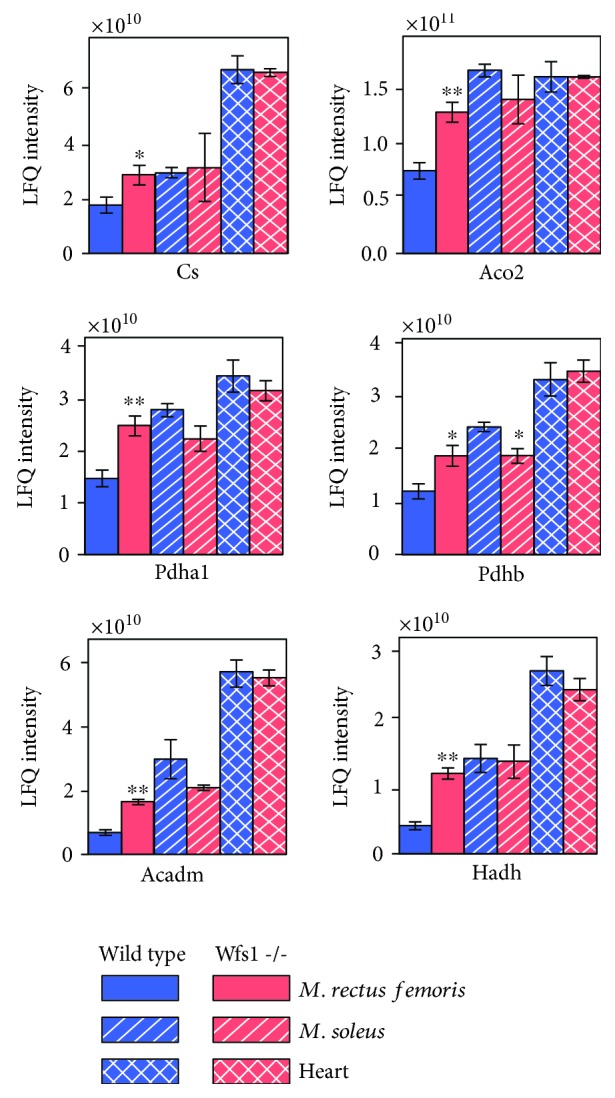
Amounts of some mitochondrial proteins and their subunits. Cs: citrate synthase; Aco2: aconitate hydratase; Pdha1: pyruvate dehydrogenase E1 component subunit alpha; Pdhb: pyruvate dehydrogenase E1 component subunit beta; Acadm: medium-chain specific acyl-CoA dehydrogenase; Hadh: hydroxyacyl-coenzyme A dehydrogenase. Compared to wild type: ∗
P < 0.05 and ∗∗
P < 0.01.